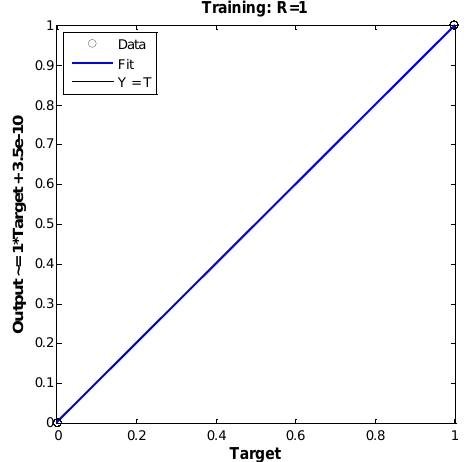
14-bus VPP system when using ANN-BBSA. Table 8 shows the total power generated in MW for each MGs when using the ANN-BBSA schedule controller for 24 h.